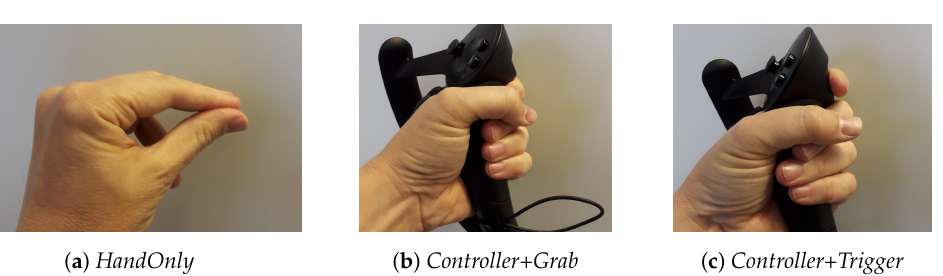
Figure 1. The interaction mechanisms to pick up the object that were used for different conditions: ( a ) in HandOnly condition, the participant uses a pinch gesture, ( b ) in Controller+Grab , the participant uses the grab gesture on the Valve Index controller, ( c ) in Controller+Trigger , the participant presses the trigger button on the